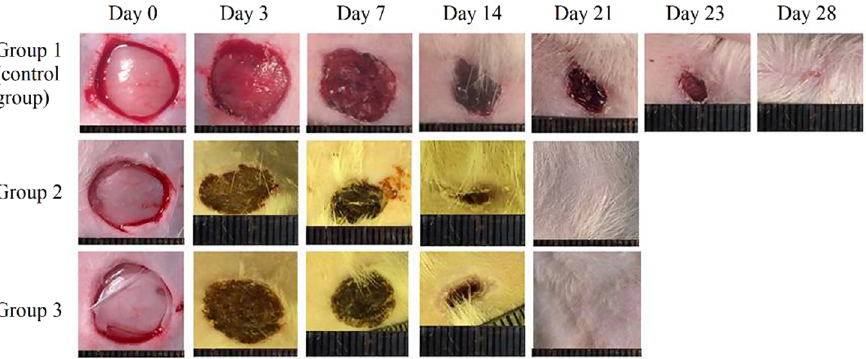
Table 3. Dynamics of full-thickness skin wound healing in Wistar rats (standard deviation values for 5 independent measurements are shown). Sign “*” indicates statistically significant differences between the experimental groups and the control group.